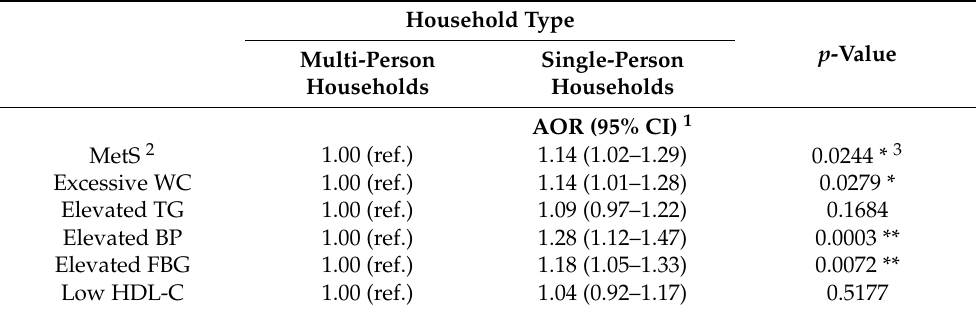
Table 6. Adjusted odds ratios with 95% confidence intervals for metabolic abnormalities among Korean adults according to household type, KNHANES